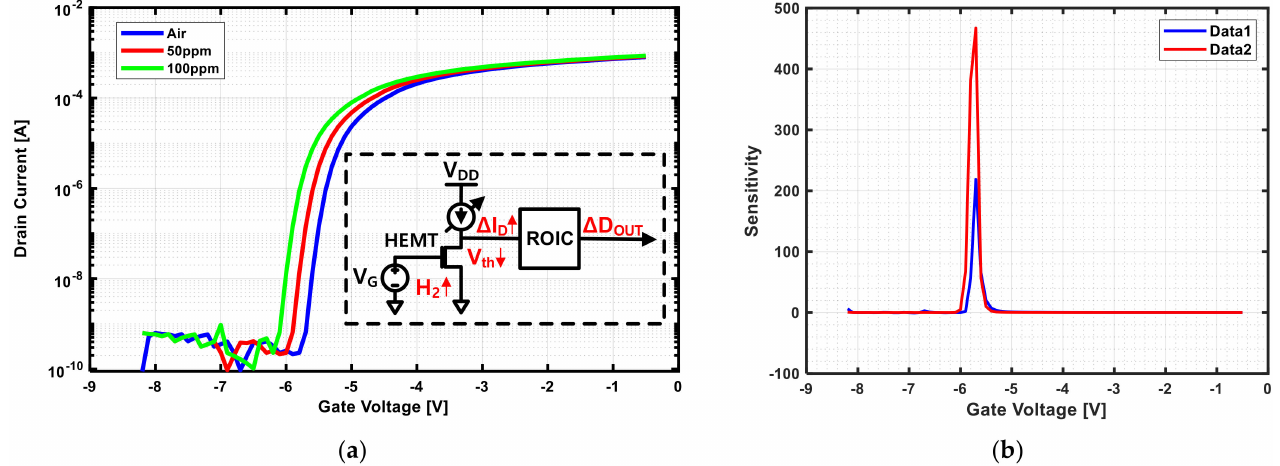
Figure 1. ( a ) HEMT device I-V curve and circuit parameters varying by gas (H 2 ) concentration; ( b ) sensitivity